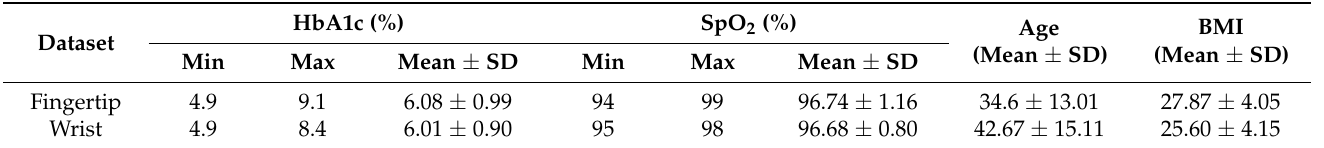
Table 3. Dataset demographics.